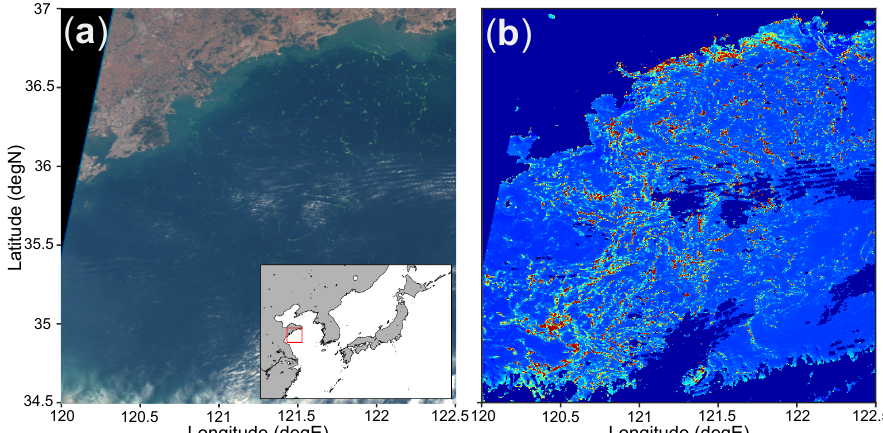
Figure 1. ( a ) An RGB image (top of atmosphere radiance) acquired by GCOM-C/SGLI (Global Change Observation Mission-Climate/Second-Generation Global Imager) on 2 July 2019. The location is off the coast of Qingdao, China (shown as a red square on the map). ( b ) Floating algae index (FAI) calculated from GCOM-C/SGLI data collected on the same day and location as in ( a ). The red-colored area corresponds to the macroalgae